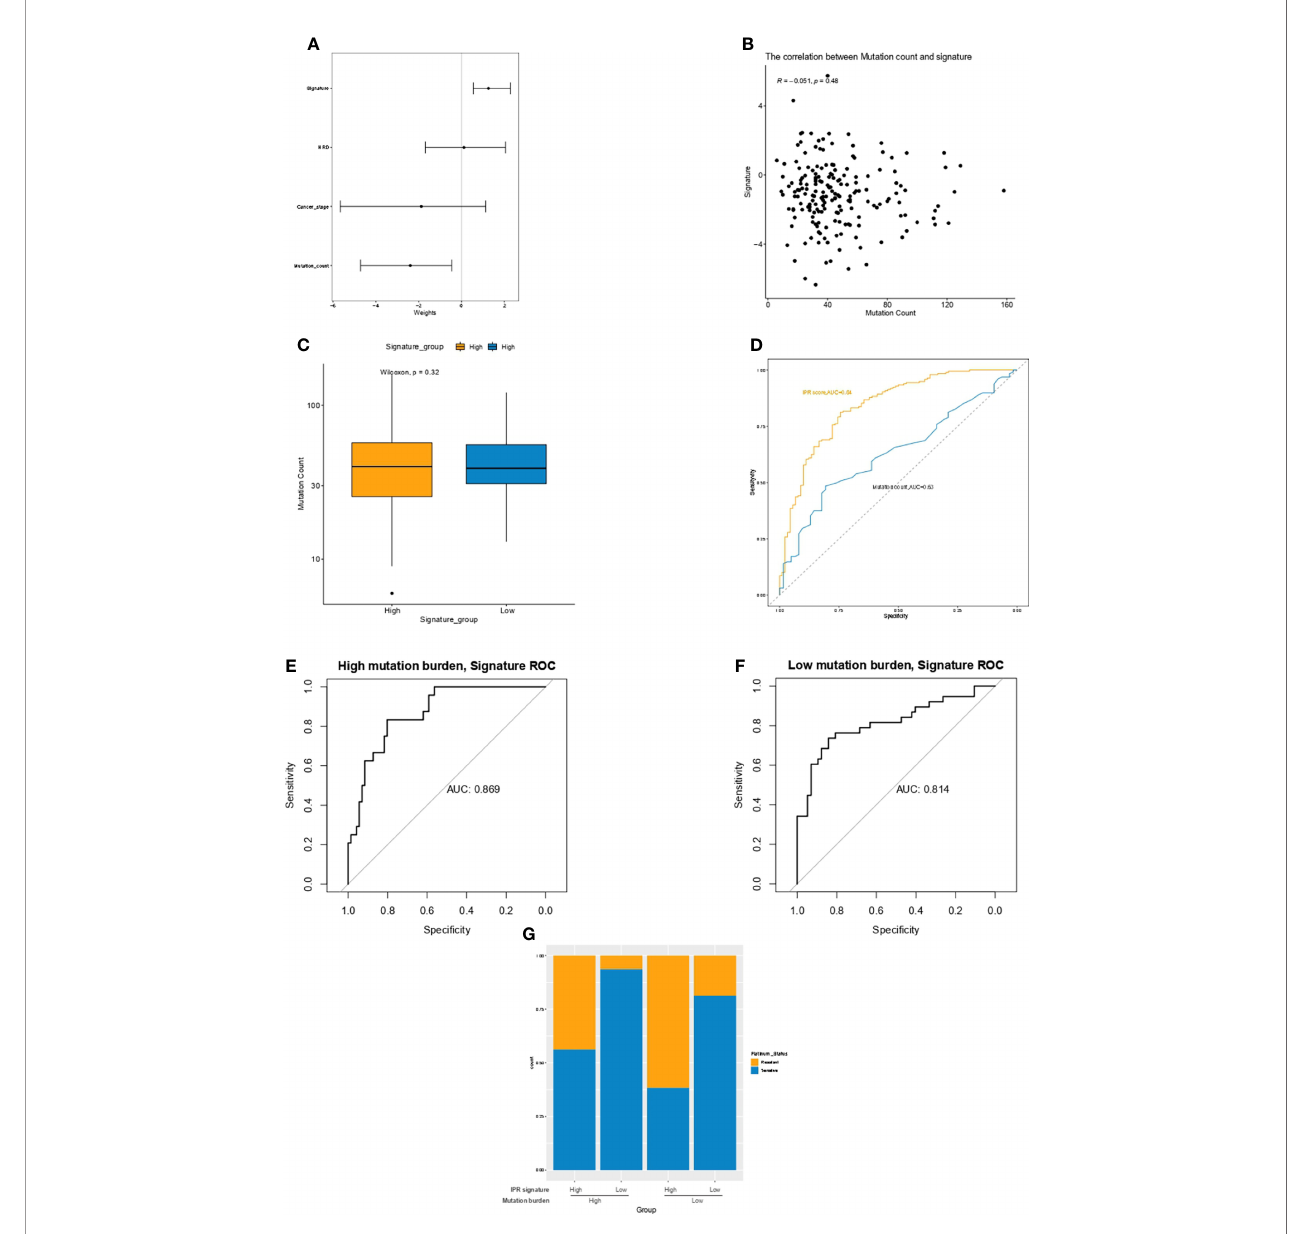
FIGURE 4 | The relationship between mutation count and the IPR signature in the training cohort. (A) Multivariate Cox regression analysis identi fi ed the mutation count and IPR signature were the two independent variable for the platinum sensitivity. (B) There was no signi fi cant correlation between IPR signature score and mutation count. (C) The difference in the IPR signature score between OV samples with HRD and HRP. There was no signi fi cance in the mutation counts between samples with high- or low-IPR signature. (D) IPR signature outperformed than mutation counts in predicting the IPR. The prediction ef fi cacy was stable in both the high- (E) and low-mutation burden (F) samples. (G) The prevalence of platinum resistance in samples with different mutation counts and IPR signature. IPR, initial platinum